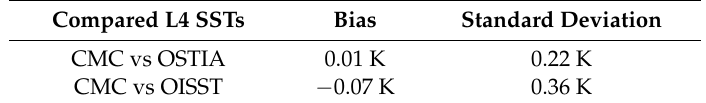
Table 5. Bias and standard deviation of the differences between L4 analyses for 31 December 2017.